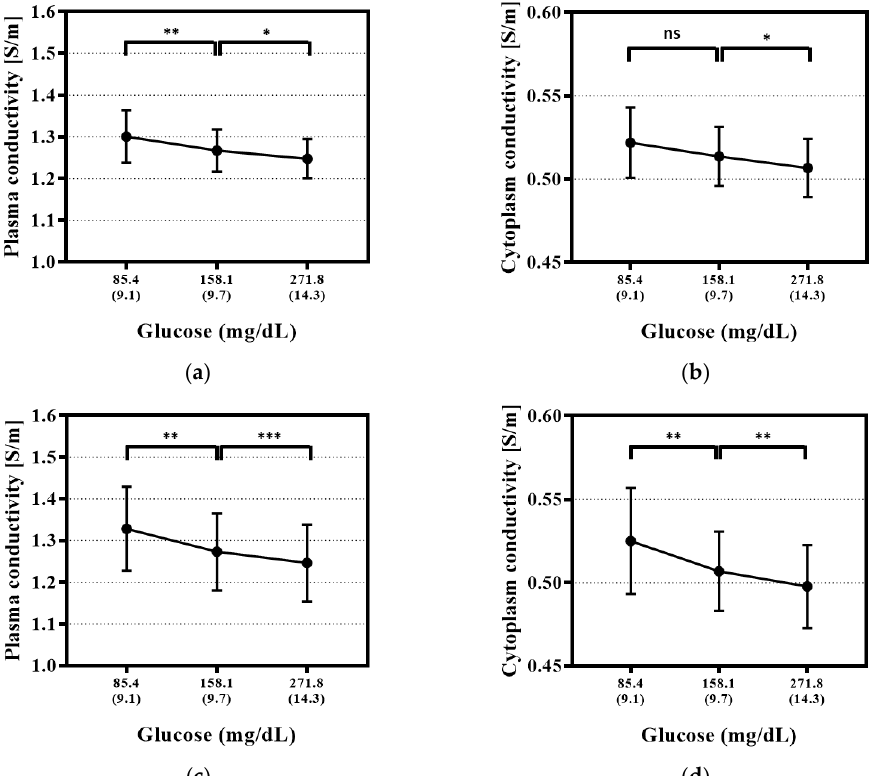
Figure 6. Conductivity trends for the plasma and cytoplasm according to the glucose levels. 10 subjects and analyzed. Each number of asterisks corresponds to the following p -values: * p -value < 0.05, ** p -value < 0.01, *** p -value < 0.001. ns: not significant. ( a ) Plasma conductivity trends before temperature correction. ( b ) Cytoplasm conductivity trends before temperature correction. ( c ) Plasma conductivity trends after temperature correction. ( d ) Cytoplasm conductivity trends after temperature